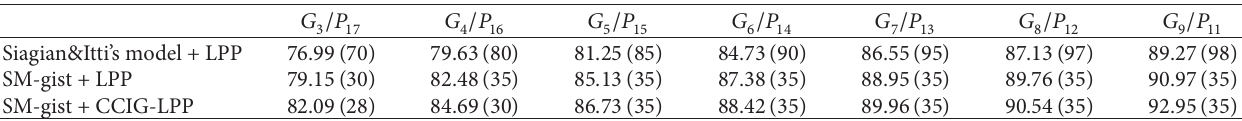
Table 1: Recognition accuracy on the subset of Sheffield buildings database of different gist feature extraction model and different dimensional reduction algorithms. The numbers in parentheses indicate the corresponding feature dimensions which give the best results after dimensionality